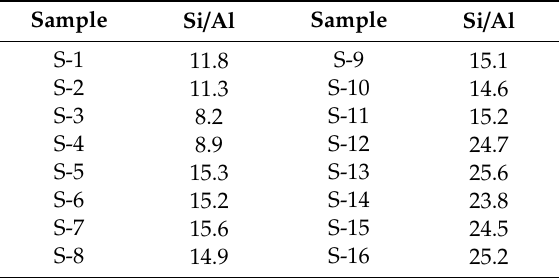
Table 2. Si / Al ratios for the obtained SSZ-13s.